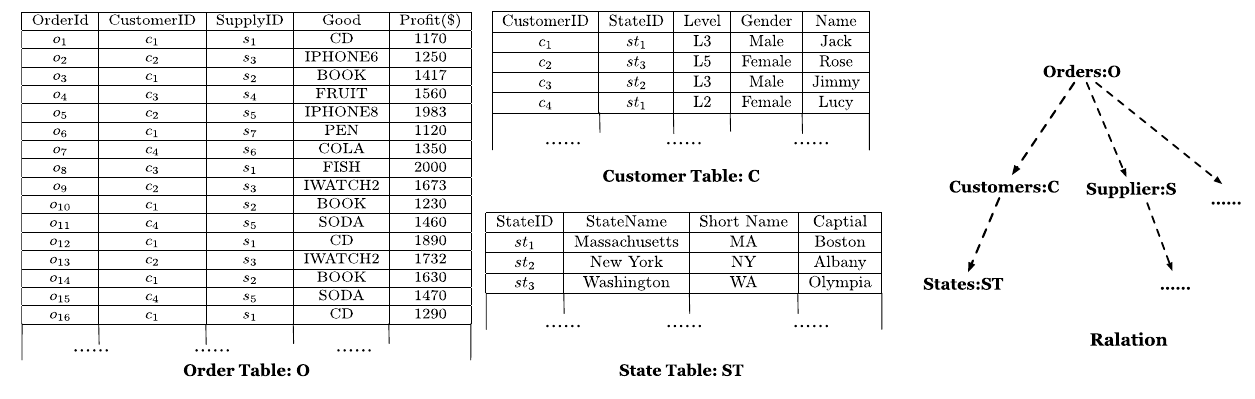
Fig. 1 Part of Relation